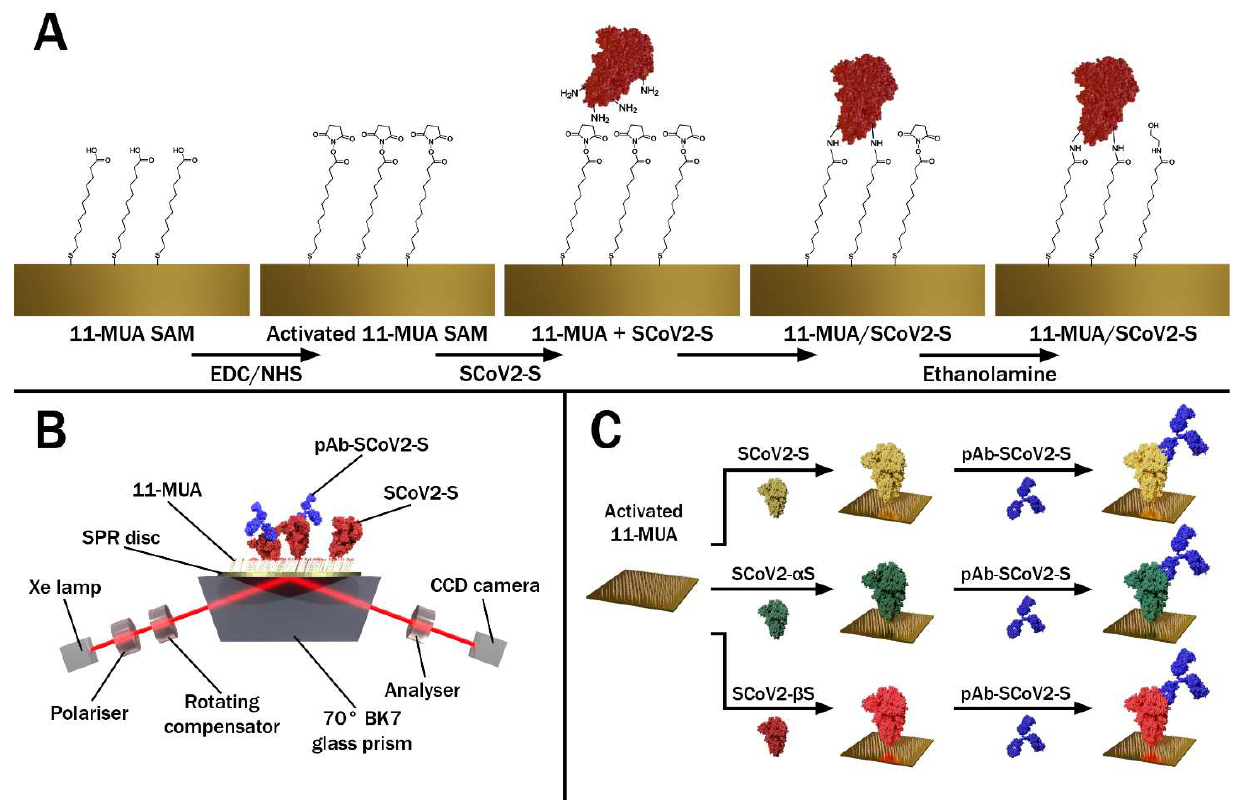
Figure 1. ( A ) Schematic representation of SARS-CoV-2 S protein (SCoV2-S, SCoV2-αS, or SCoV2- βS) covalent immobilization on the gold-coated SPR sensor disc pre-modified with 11-MUA SAM. ( B ) The principle scheme representing total internal reflection ellipsometry measurements. ( C ) Schematic representation of SCoV2-S, SCoV2-αS, and SCoV2-βS covalent immobilization and interaction with specific polyclonal antibodies (pAb-SCoV2-S).